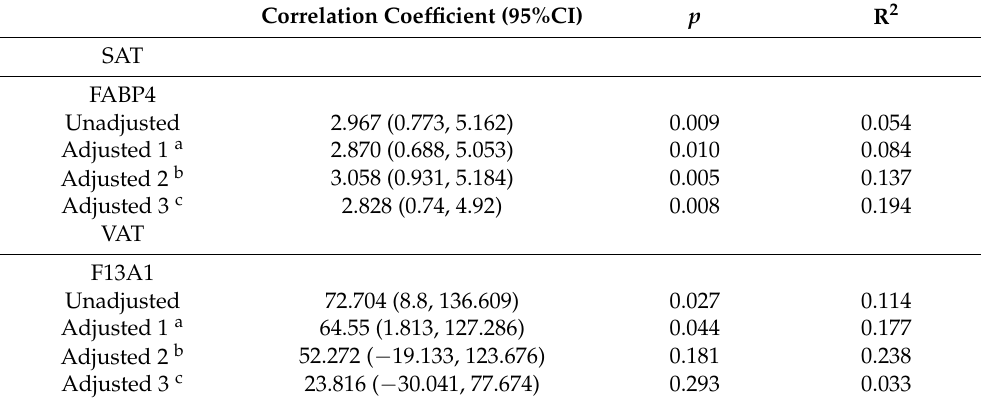
Table 3. Regression analysis between gene expression in WAT and TG